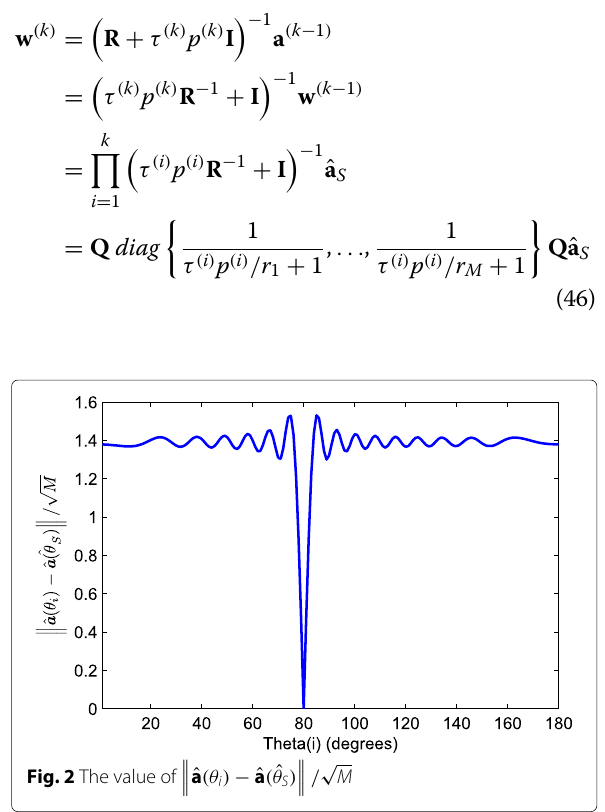
Fig. 2 The value